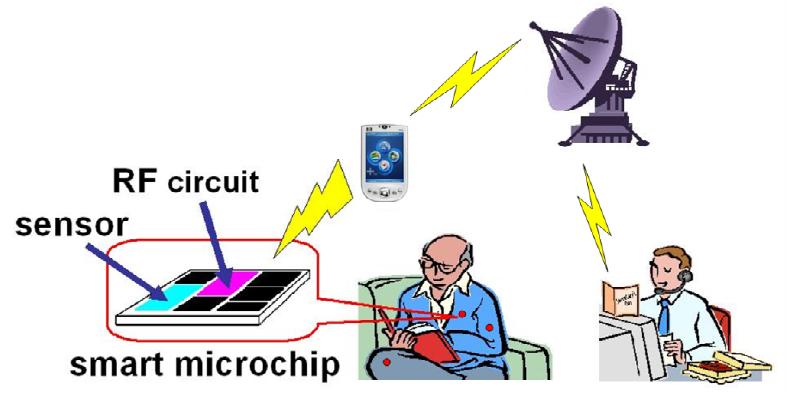
Figure 1. Concept diagram of intelligent human sensing system [3].